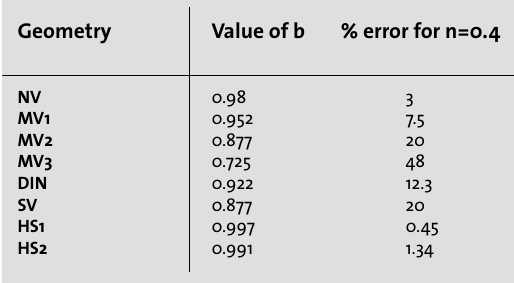
Table 3: Values of b for the various Haake concentric- cylinder geometries, and the % error the would ensue if the Newtonian shear rate is used to calculate the viscosi- ty for a power-law liquid with n =